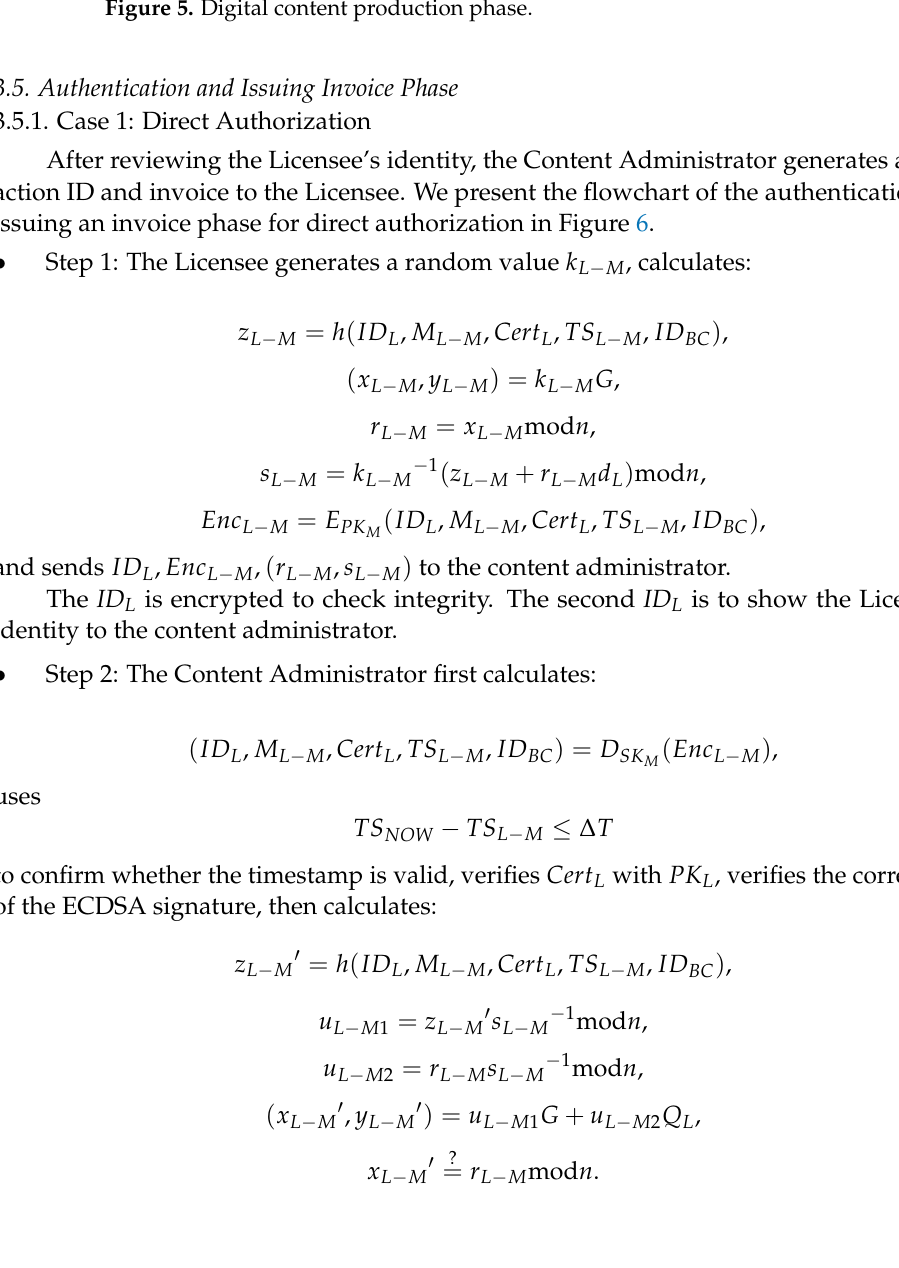
Figure 5. Digital content production phase.